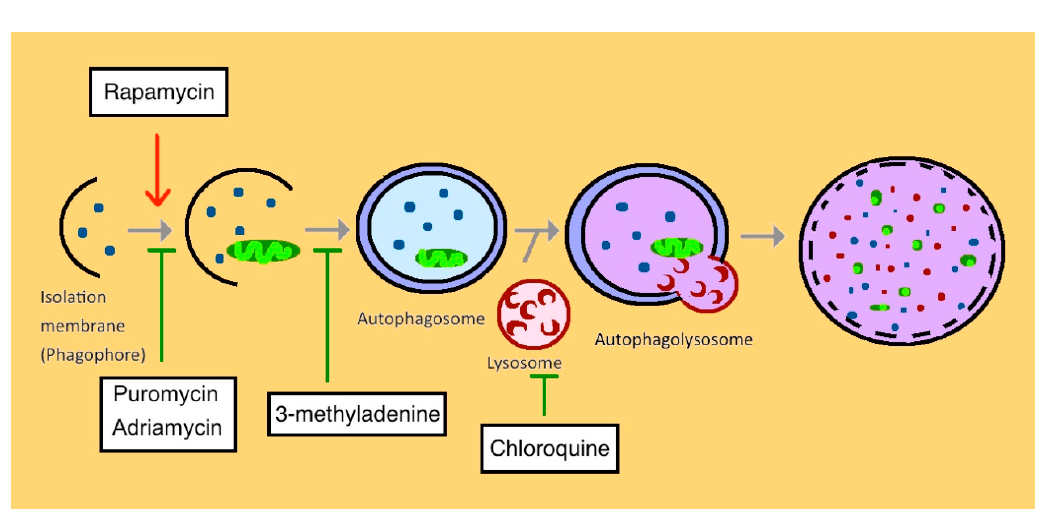
Figure 3. Overview of the different medications that regulate autophagy in different steps,